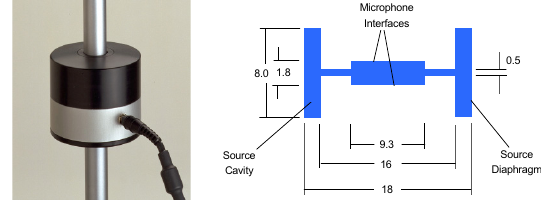
Fig. 10. Typical comparison coupler with built-in sound source for calibration of WS2 microphones. It is shown beside the cross-sectional view of its air-filled cavity.